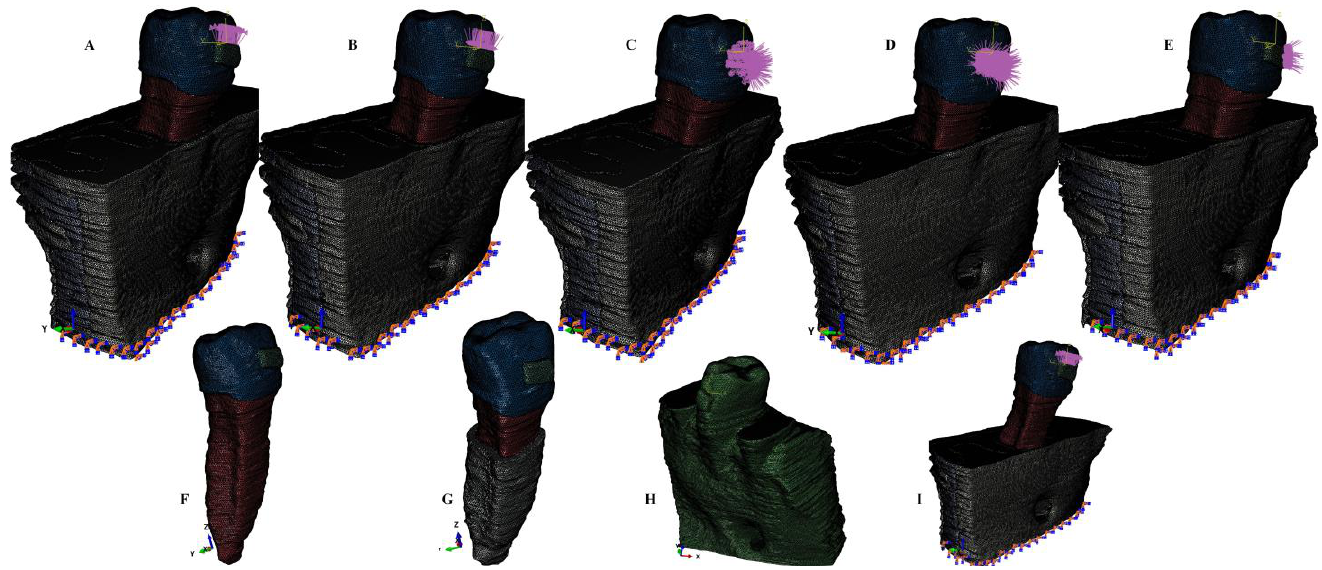
Figure 1. Mesh model: ( A ) 2nd lower right premolar model with 4 mm bone loss and applied vector for extrusion; ( B ) 2nd lower right premolar model with 4 mm bone loss and applied vector for intrusion; ( C ) 2nd lower right premolar model with 4 mm bone loss and applied vector for rotation; ( D ) 2nd lower right premolar model with 4 mm bone loss and applied vector for tipping; ( E ) 2nd lower right premolar model with 4 mm bone loss and applied vector for translation, ( F ) tooth model; ( G ) tooth model with 4 mm reduced PDL; ( H ) no bone loss 3D model; ( I ) 2nd lower right premolar model with 8 mm bone loss and applied vector for extrusion.